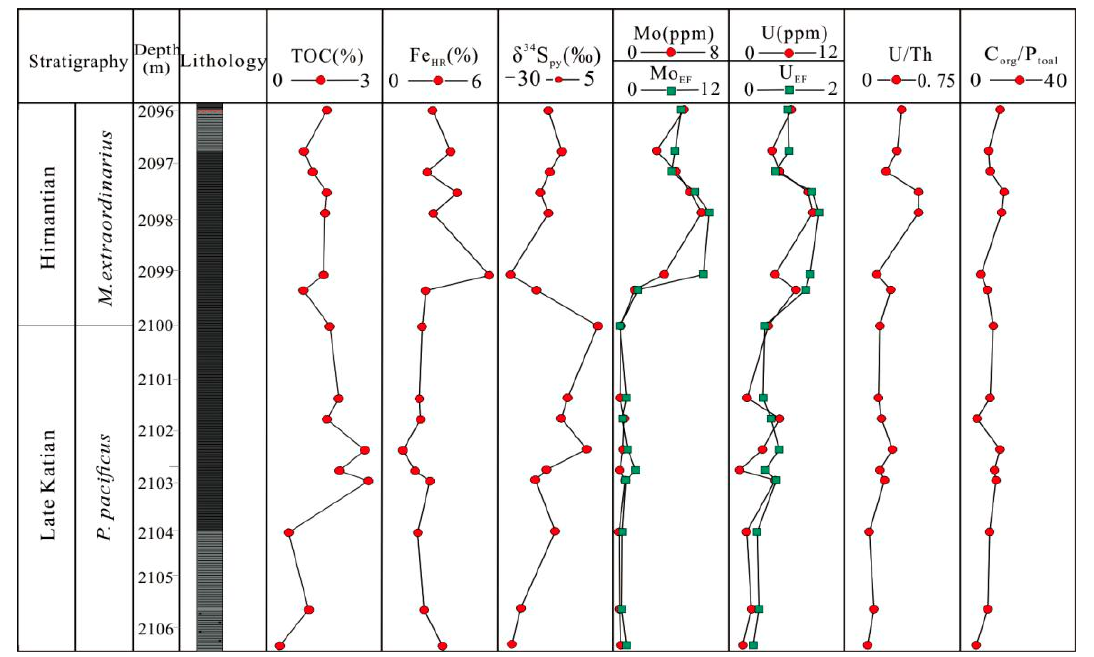
Figure 3. Chemostratigraphic profiles of TOC, Fe HR , δ 34 Spy, Mo-U concentrations, Mo EF and U EF , C org /P totl and U/Th of the well ZY5. Lithological legend and abbreviations as in Figure 1.